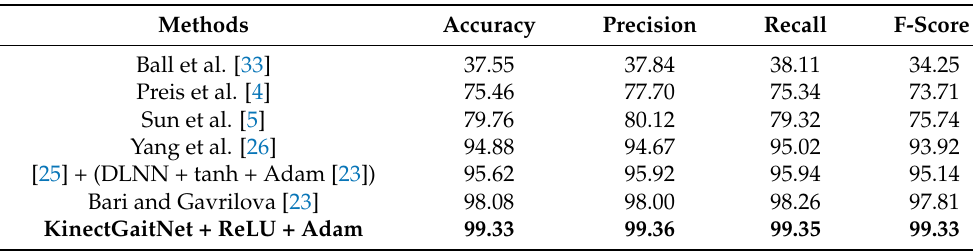
Table 11. Performance comparison of the proposed method with prior research on the KGB dataset. The best performance is shown in